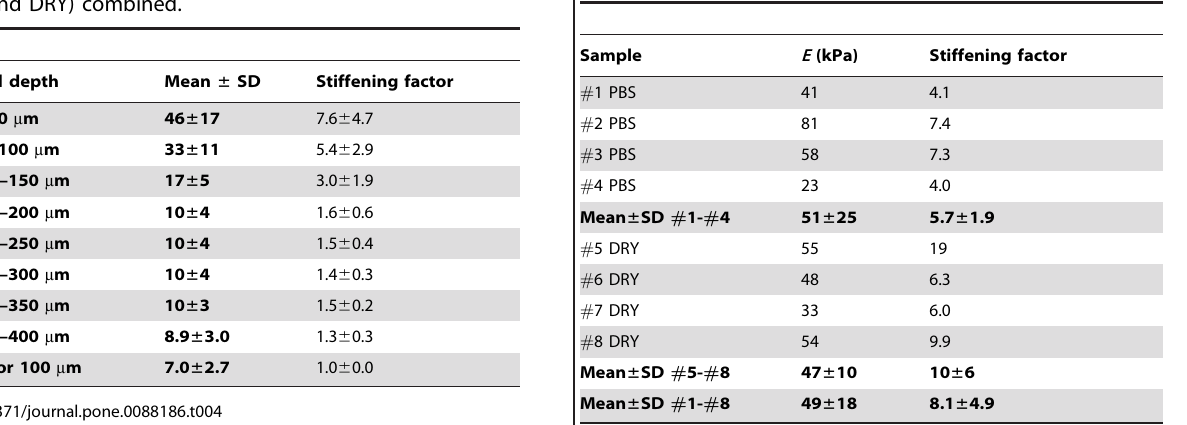
Table 5. Young’s moduli E (kPa) and stiffening factors at the corneal surface.